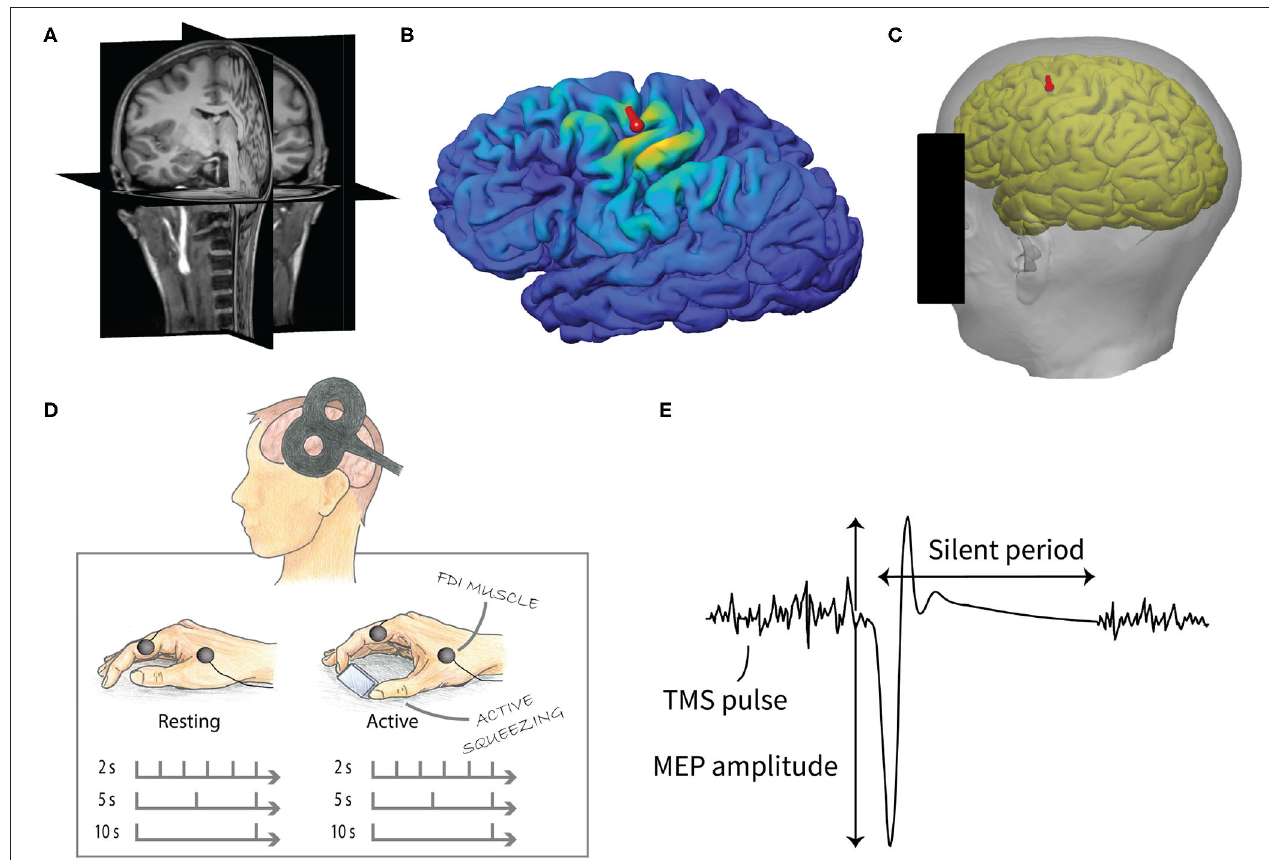
FIGURE 1 | Experimental design of the study. (A) T1- (pictured) and T2-weighted MR images were used to create individual cortical reconstructions. (B) The induced electric fields were calculated based on computer simulations. (C) The location of the TMS coil (red mark) for the experiment was predetermined from the cortical reconstruction in order to obtain the optimal cortical location for the FDI muscle. (D) TMS measurement consisted of two parts, resting and active condition. Both included three sets of 30 stimuli with 2, 5, and 10 s IPI. The order of the conditions and IPIs were pseudo-randomized. (E) MEPs were recorded from the FDI muscle of the right hand. The peak-to-peak amplitude of the MEPs was used in the analysis. The silent period was defined as the duration between the MEP onset and the resumption of the voluntary